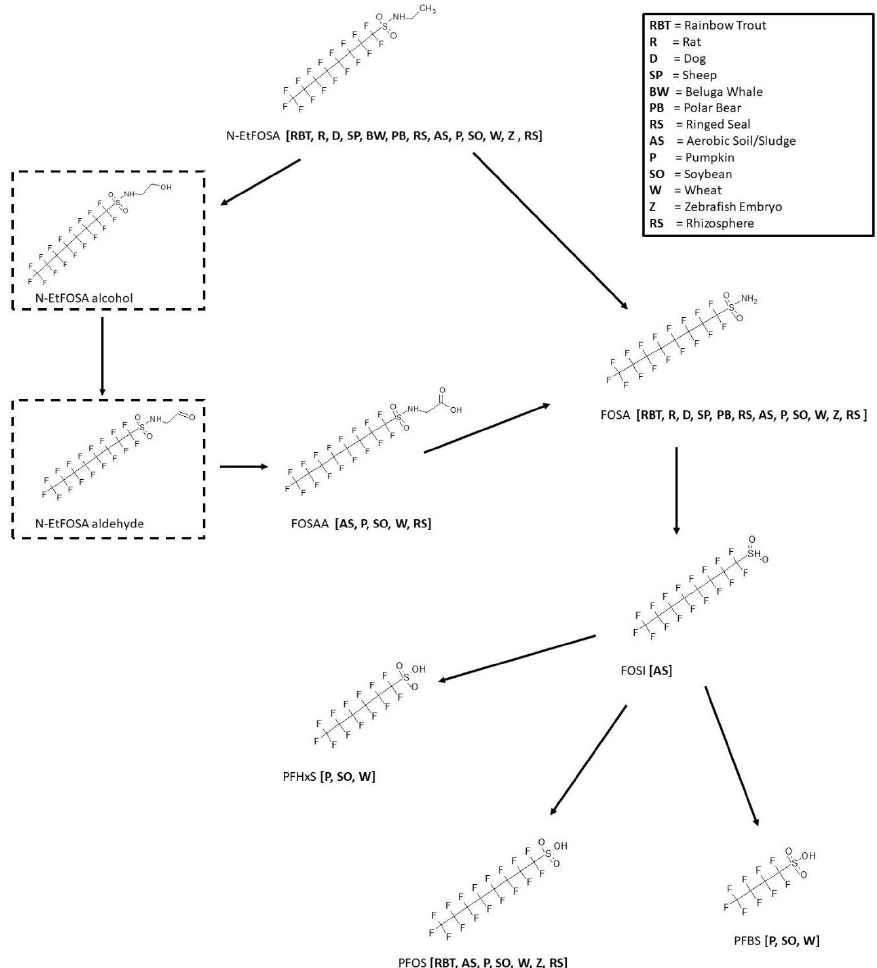
Figure 9. Metabolic map for N -Ethylperfluorooctane-1-sulfonamide (Sulfuramid; N-EtFOSA) as found in rainbow trout [24], rat [25 – 28], dog [27], sheep [29], beluga whale [26], polar bear [26], ringed seal [26], aerobic soil/sludge [31,32], pumpkin [34], soybean [34], wheat [34], zebrafish embryo [30], and rhizospheres [33]. Structures as shown within the dotted box were assumed by the authors but were not actually observed metabolites in the studies.